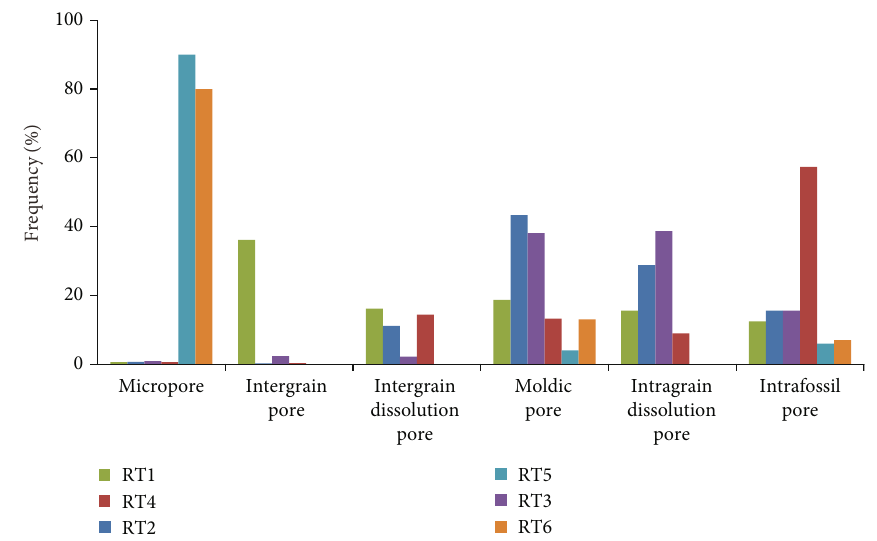
Figure 4: Frequency distribution of pore types in di ff erent rock types.